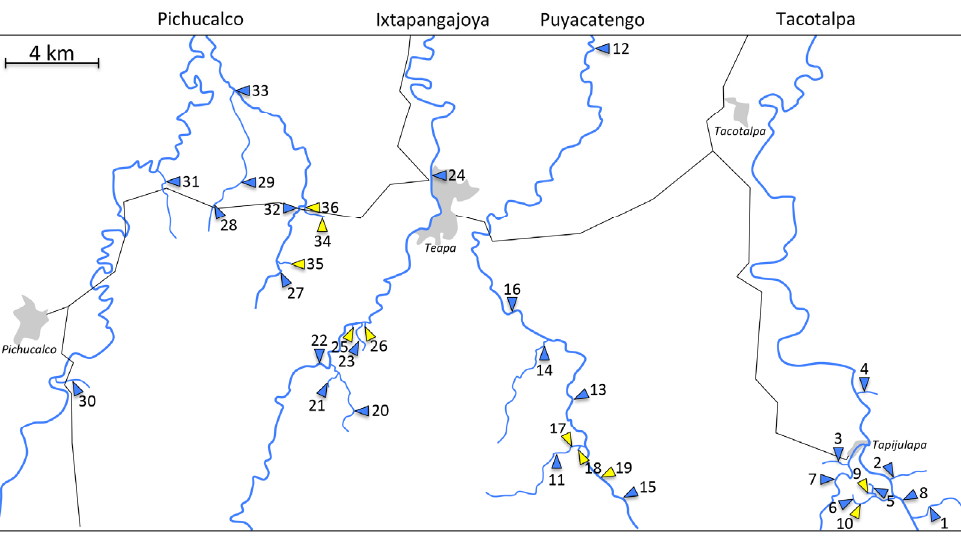
Figure 3. Map of the locations of southern Mexican sulphide springs (yellow arrows) and non-sulphidic reference habitats (blue arrows) used in the case study on patterns of biodiversity in sulphidic habitats. Numbers correspond to IDs in Table